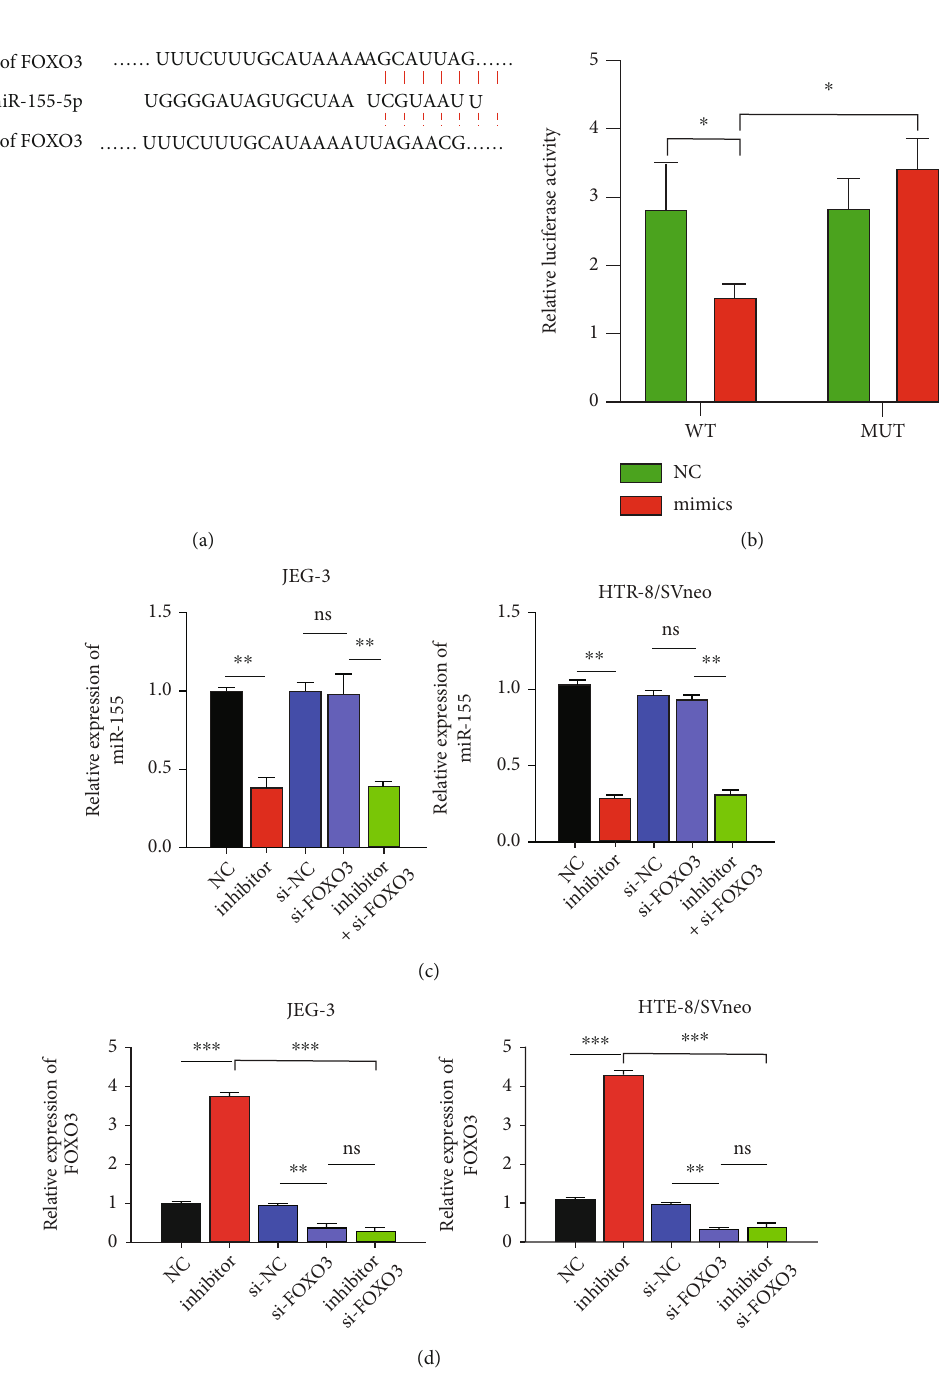
Figure 4: miR-155 binds and negatively regulates FOXO3 expression. (a) The binding site between miR-155 and FOXO3. (b) Relative luciferase activity was measured in 293T cells cotransfected with miR-155 mimics and WT FOXO3 or MUT FOXO3. HTR8/SVneo and JEG-3 cells were transfected with NC, inhibitor, si-NC, si-FOXO3, and inhibitor + si-FOXO3, respectively. RT-qPCR assay was used to determine the expression of miR-155 (c) and FOXO3 (d) mRNA in the above-transfected cells. ∗ P < 0 : 05 , and ∗∗ P < 0 : 01 . ns: not signi fi